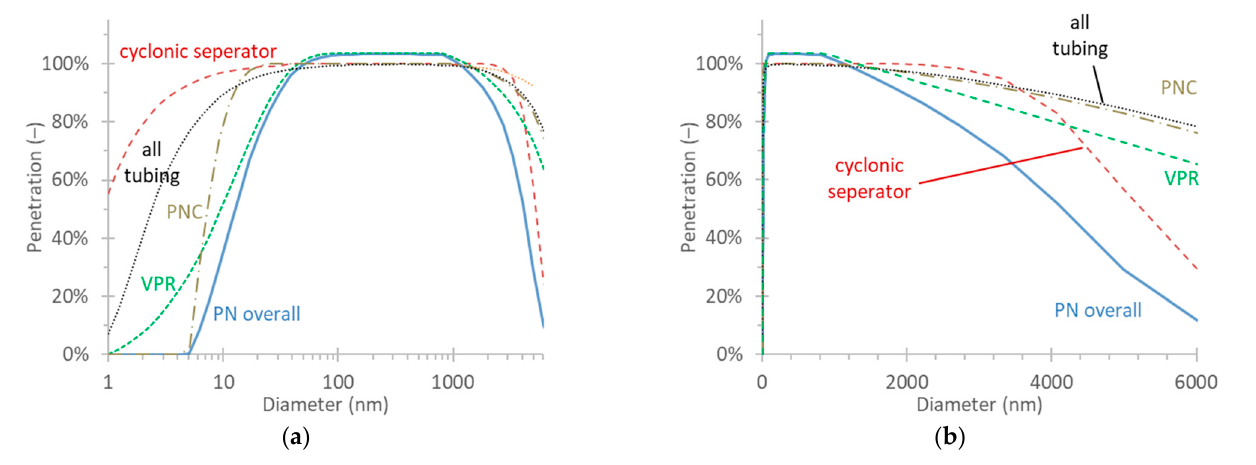
Figure 3. Penetration of the PN setup assuming minimum losses and using a 5 µ m cyclonic separator (“max penetration” setup): ( a ) logarithmic x-axis; ( b ) linear x-axis.